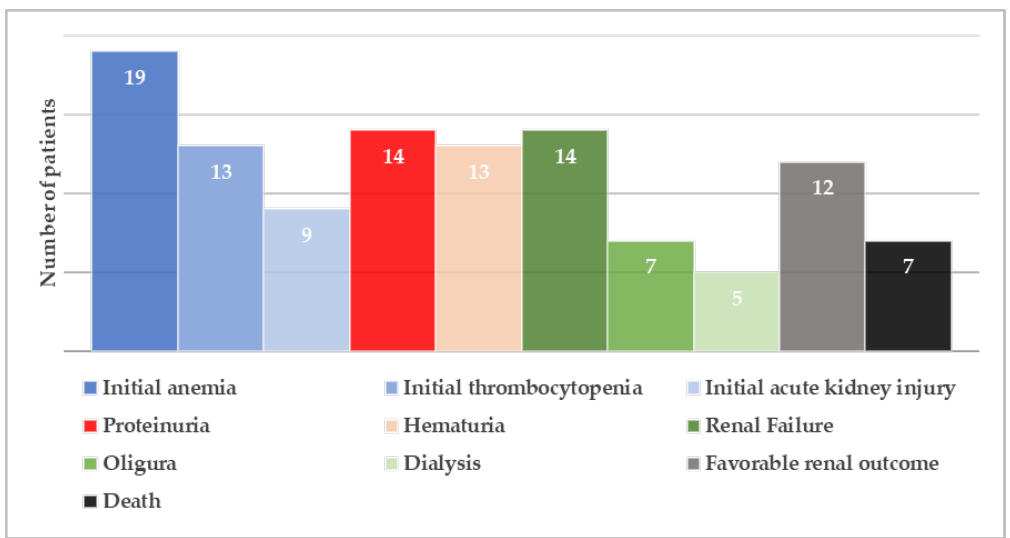
Figure 3. Renal manifestations at initial presentation and during the course of the disease of reported 19 patients with early-onset cobalamin C defect and hemolytic uremic syndrome .